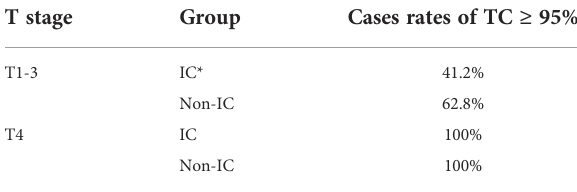
TABLE 2 Target Coverage of